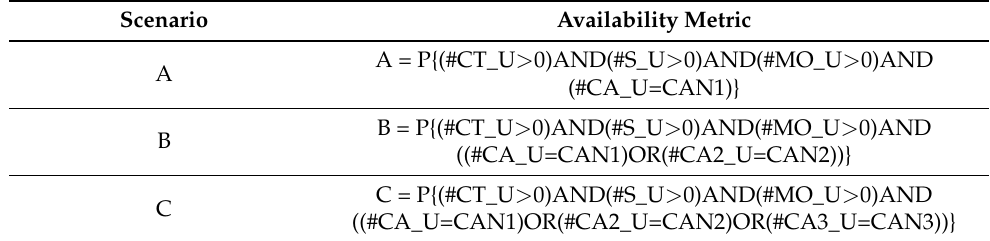
Table 6. Reward definitions of availability metric.